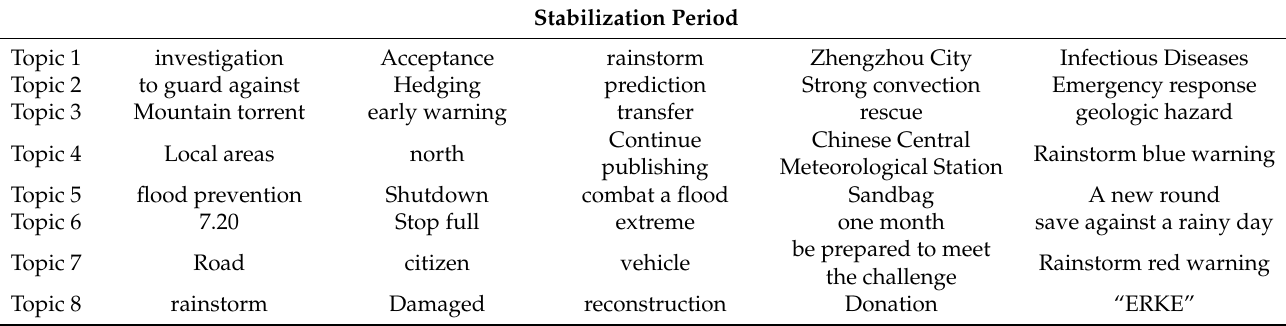
Table 4. Text topic extraction results in the stabilization